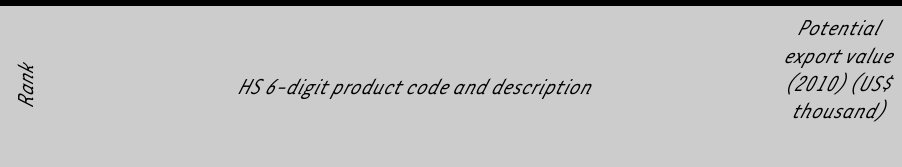
TABLE 10: Products with the highest potential export value (US$ thousand) for South Africa in South